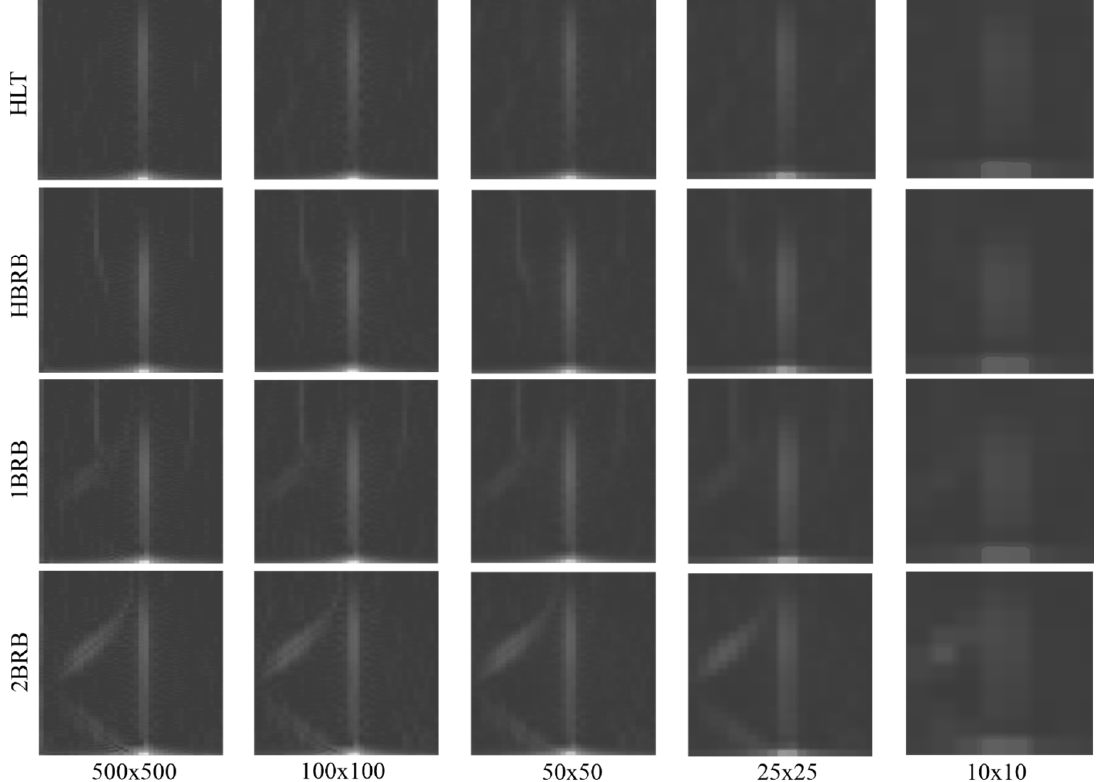
Figure 12. Images for different sizes.